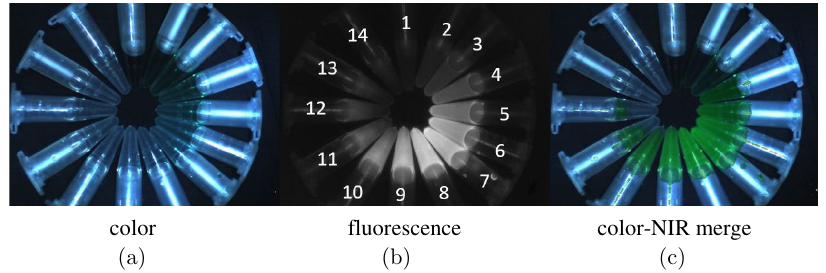
Fig. 1. The image of ICG solution of di®erent concentration. No. 1 ICG concentration is 1677.51 mol/L, then concentration is halved in turn, No. 14 ICG concentration is 0.21 mol/L.